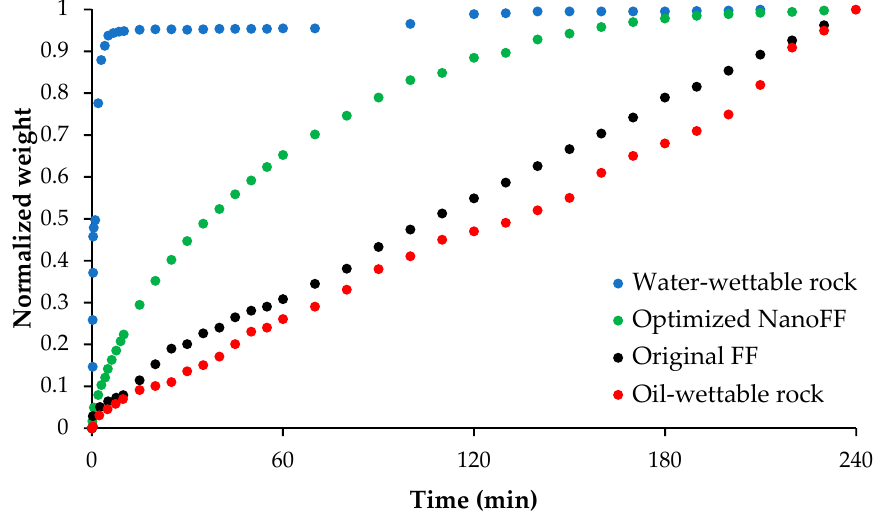
Figure 11. Spontaneous imbibition curves made at 25 °C and atmospheric pressure to the synthetic Ottawa sand cores for the water-wettable and the oil-wettable systems and the last one after contact with the original FF and the optimized NanoFF for 16 h at 87.7 °C and 50 psi.